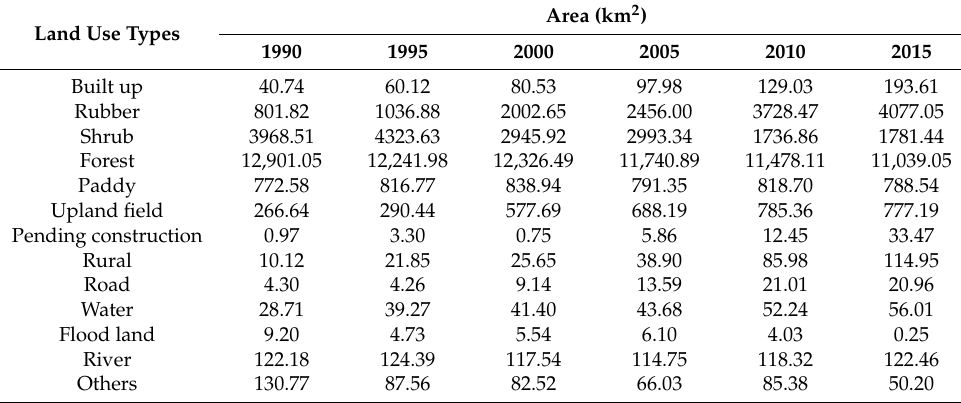
Table 3. Area of land use types in Xishuangbanna from 1990 to 2015.